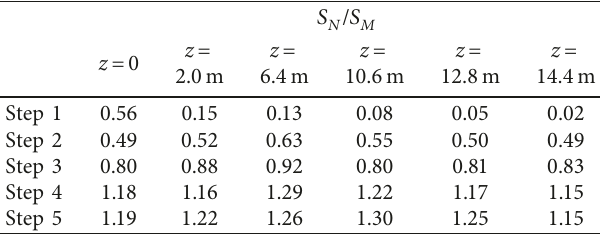
Table 4: Comparison of the numerical results with the monitoring